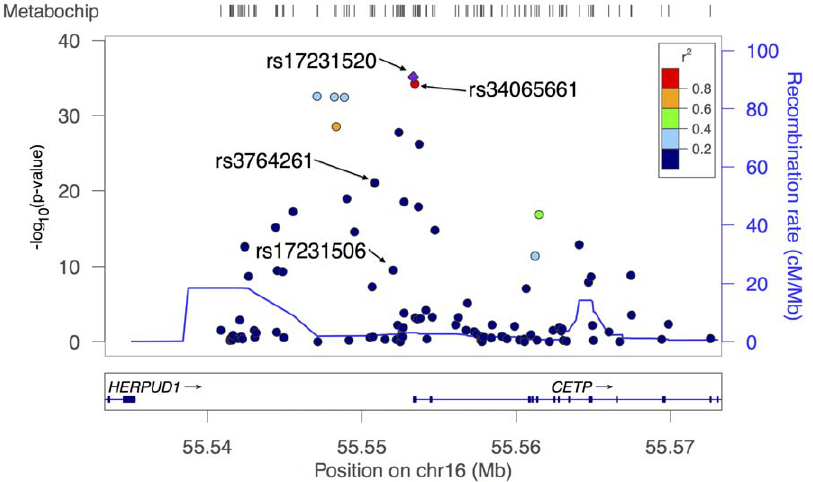
Figure 4. Regional association plot for HDL-C results from PAGE in African Americans near the CETP locus. SNPs are colored by their LD ( r 2 ) in the same sample with